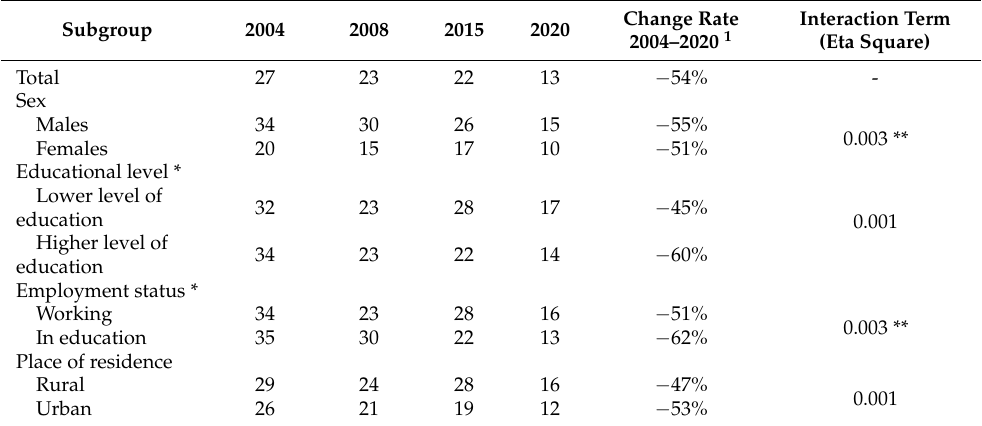
Table 1. Change in mean per capita consumption (g/d) for different subgroups of adolescents and young adults between 2004 and